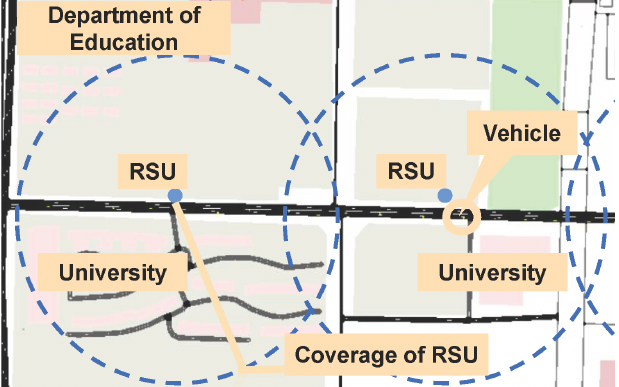
Figure 4. Evaluation scenario based on